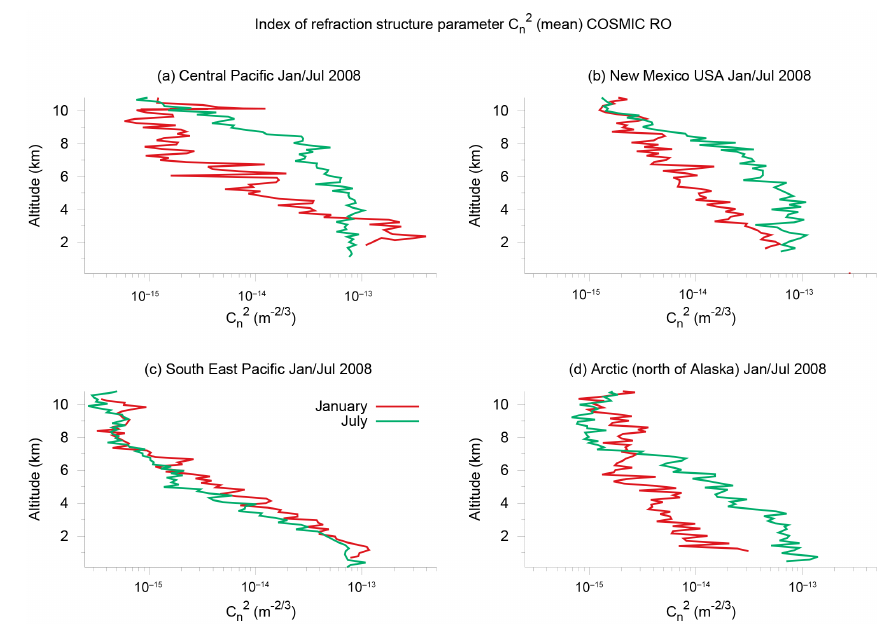
Figure 4. The index of refraction structure parameter C 2 n inferred from CT signal amplitude of COSMIC RO